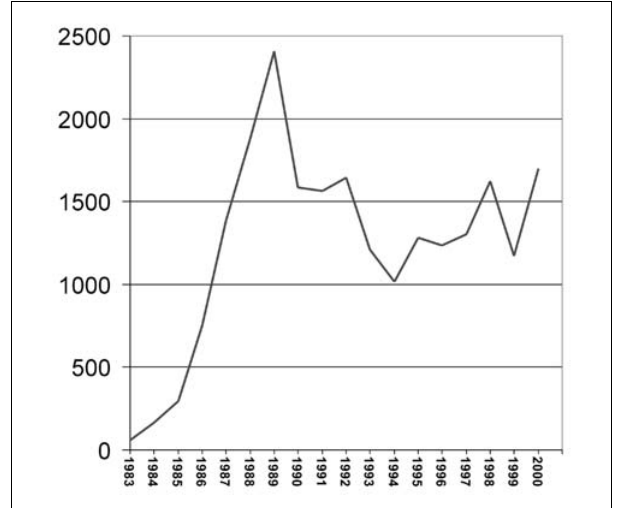
Figure 1) Human laboratory confirmed cases of Escherichia coli O157:H7 in Canada between 1983 and